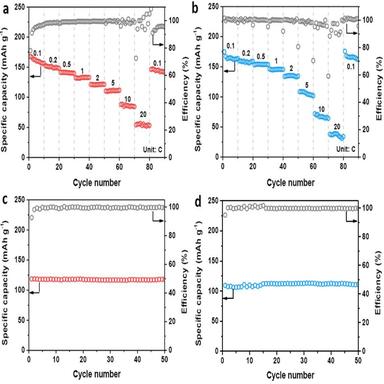
Rate performance of (a) Li||LVP and (b) Li||LTO. Cycle performance of (c) Li||LVP and (d) Li||LTO at 5C rate.